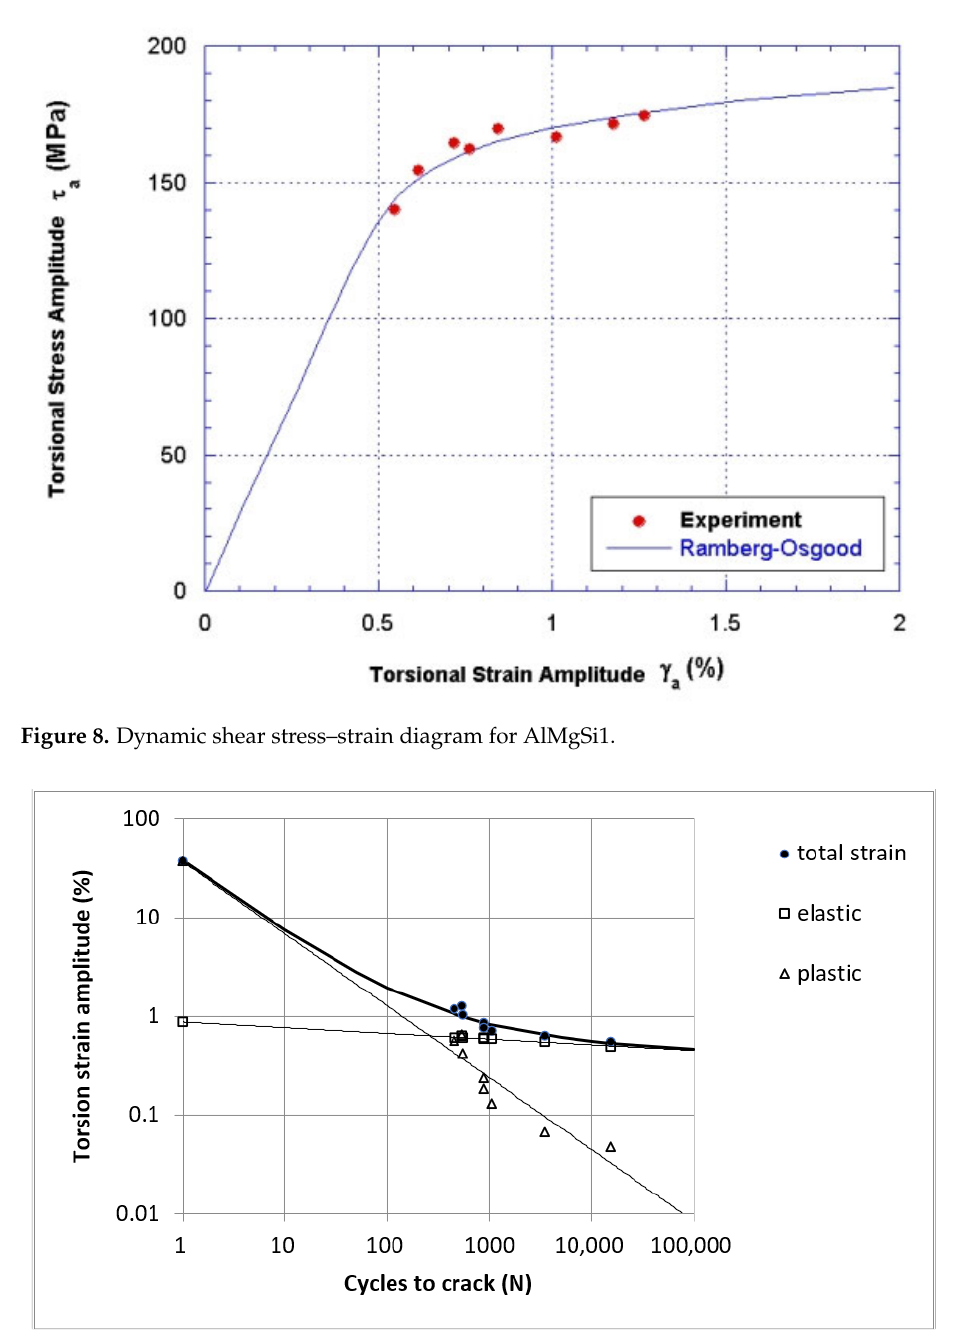
Figure 9. Torsional shear strain life diagram for AlMgSi1.